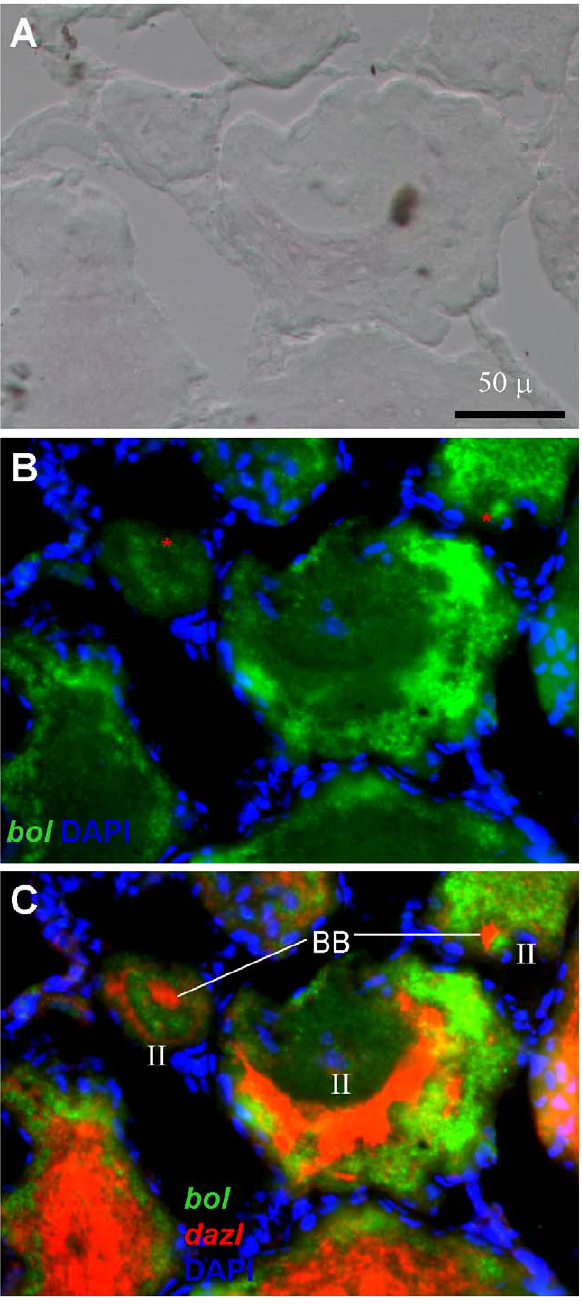
Figure 8. Expression of boule and dazl transcripts in oogenesis. (A) Bright field. (B) boule signal. (C) boule and dazl signals. Notably, the dazl but not boule RNA is seen to be concentrated in the Balbiani’s body (BB).